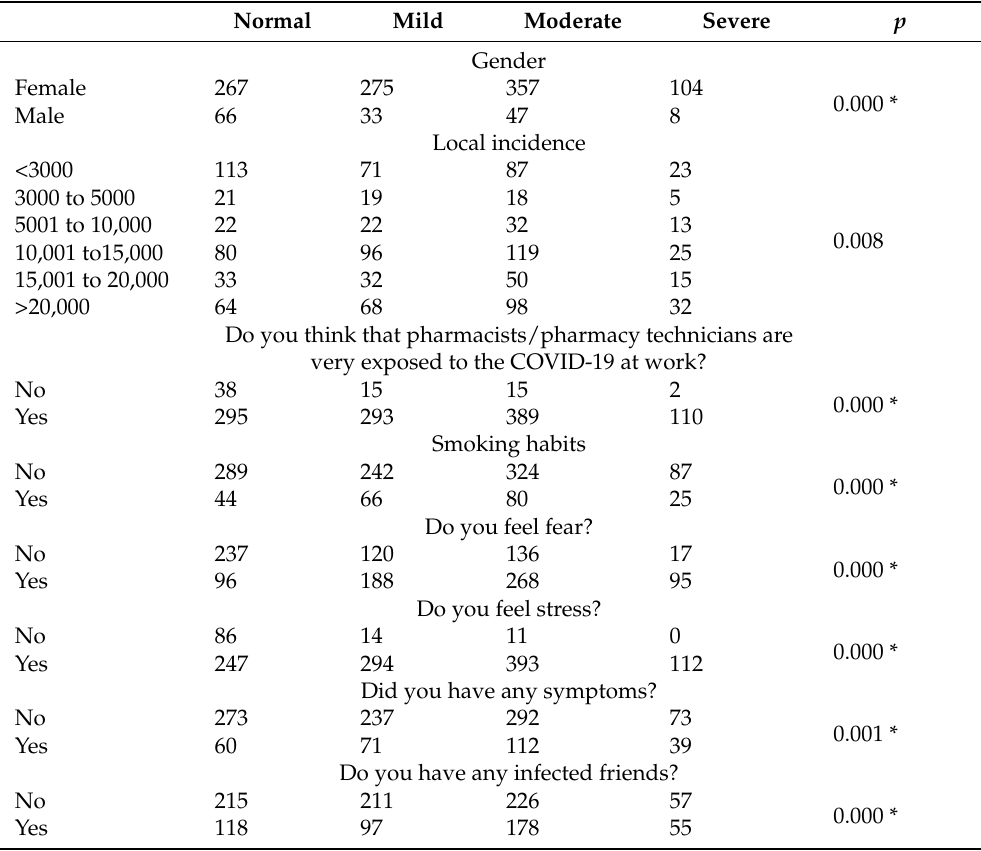
Table 5. Correlation analysis of HADS-A levels.